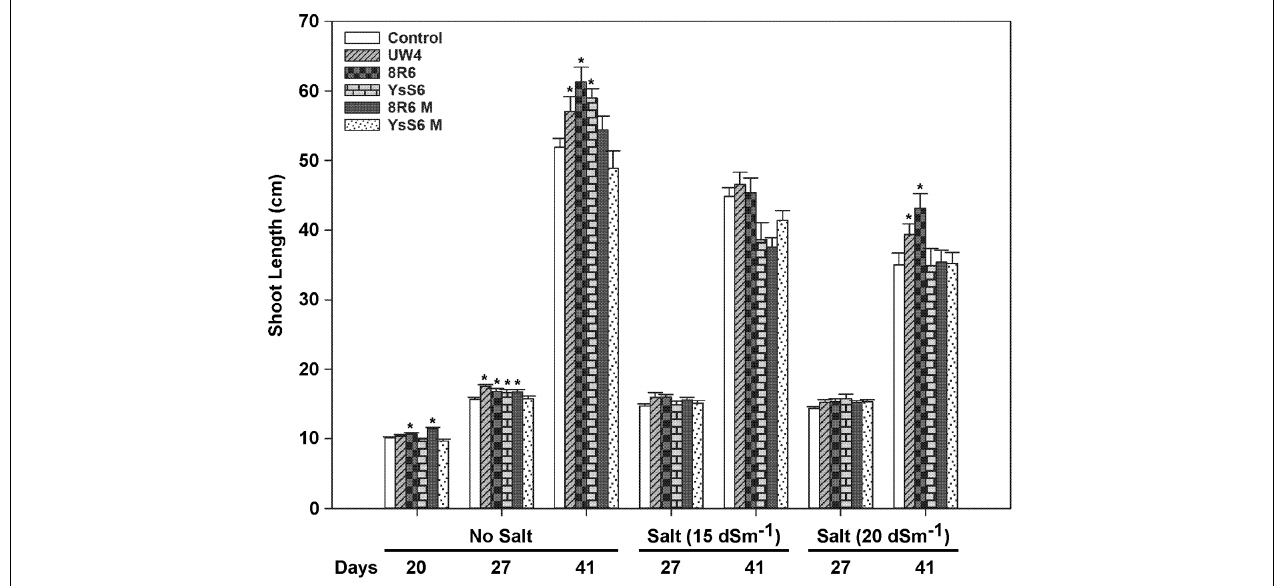
FIGURE 1 | The effect of soil inoculation with plant growth-promoting bacteria (PGPB) on the shoot length of camelina plants grown in the absence, or presence of, salt (15 and 20 dSm − 1 ). Soil was treated with buffer (control), Pseudomonas putida UW4, P. migulae 8R6 or its acdS mutant 8R6M, P. fluorescens YsS6 or its acdS mutant YsS6M. Salt was applied 20 days after sowing. Error bars indicate standard error ( n = 15). A two-way ANOVA and Tukey post-test were used to detect significant differences between groups. Asterisks ( ∗ ) above bars indicate values that are significantly different ( p < 0.05) from the control on days when measurements were